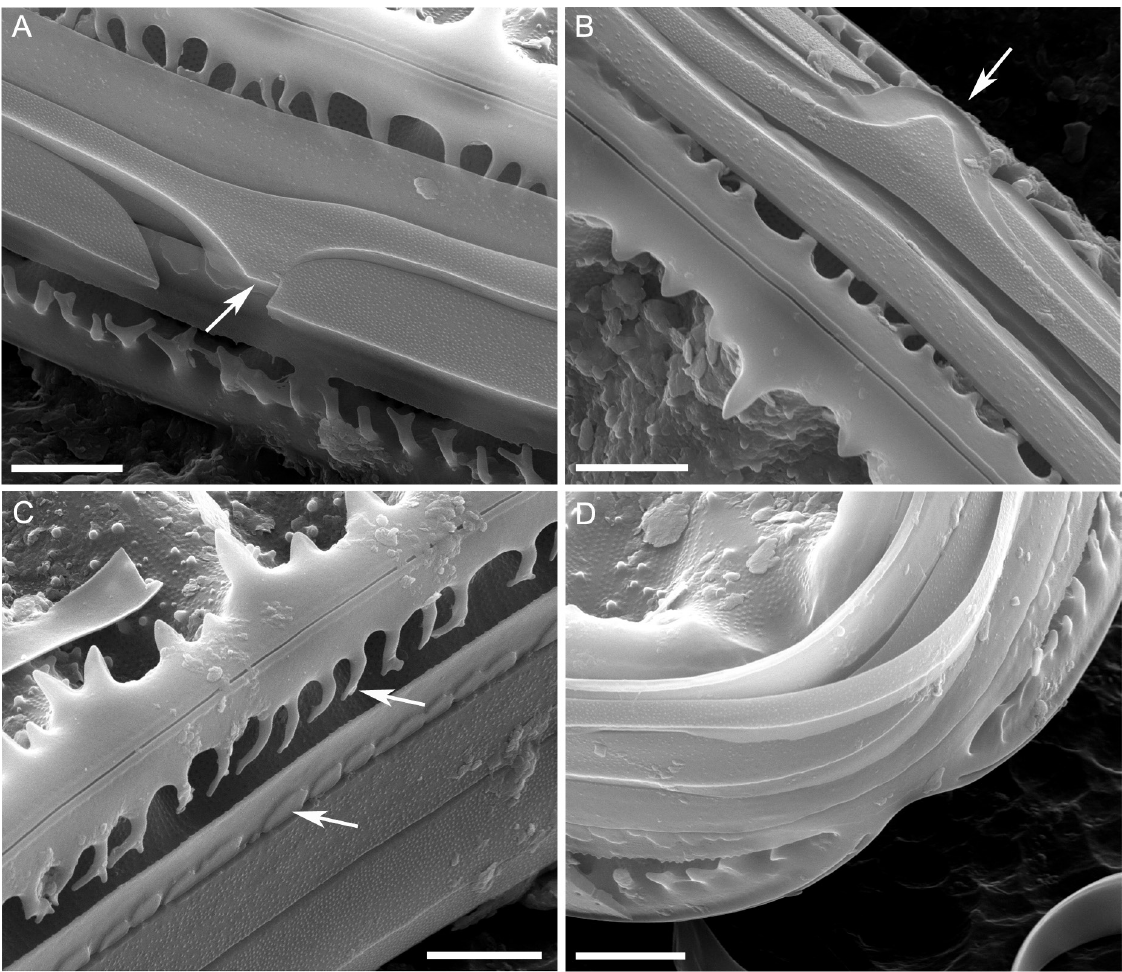
Fig. 3. Surirella ebalensis sp. nov., type material from sample CCA 2070, Lomami River, DR Congo, SEM. External view. A–B . Detail of the girdle showing a part of a girdle with ligula (arrow) and the neighbouring interrupted band. C . Detail of the valve mantle with the draped silica spines (arrow) and the silica plaques (arrow) near the edge of the mantle and the valvocopula. D . Detail of the girdle band near the pole. Scale bars = 2